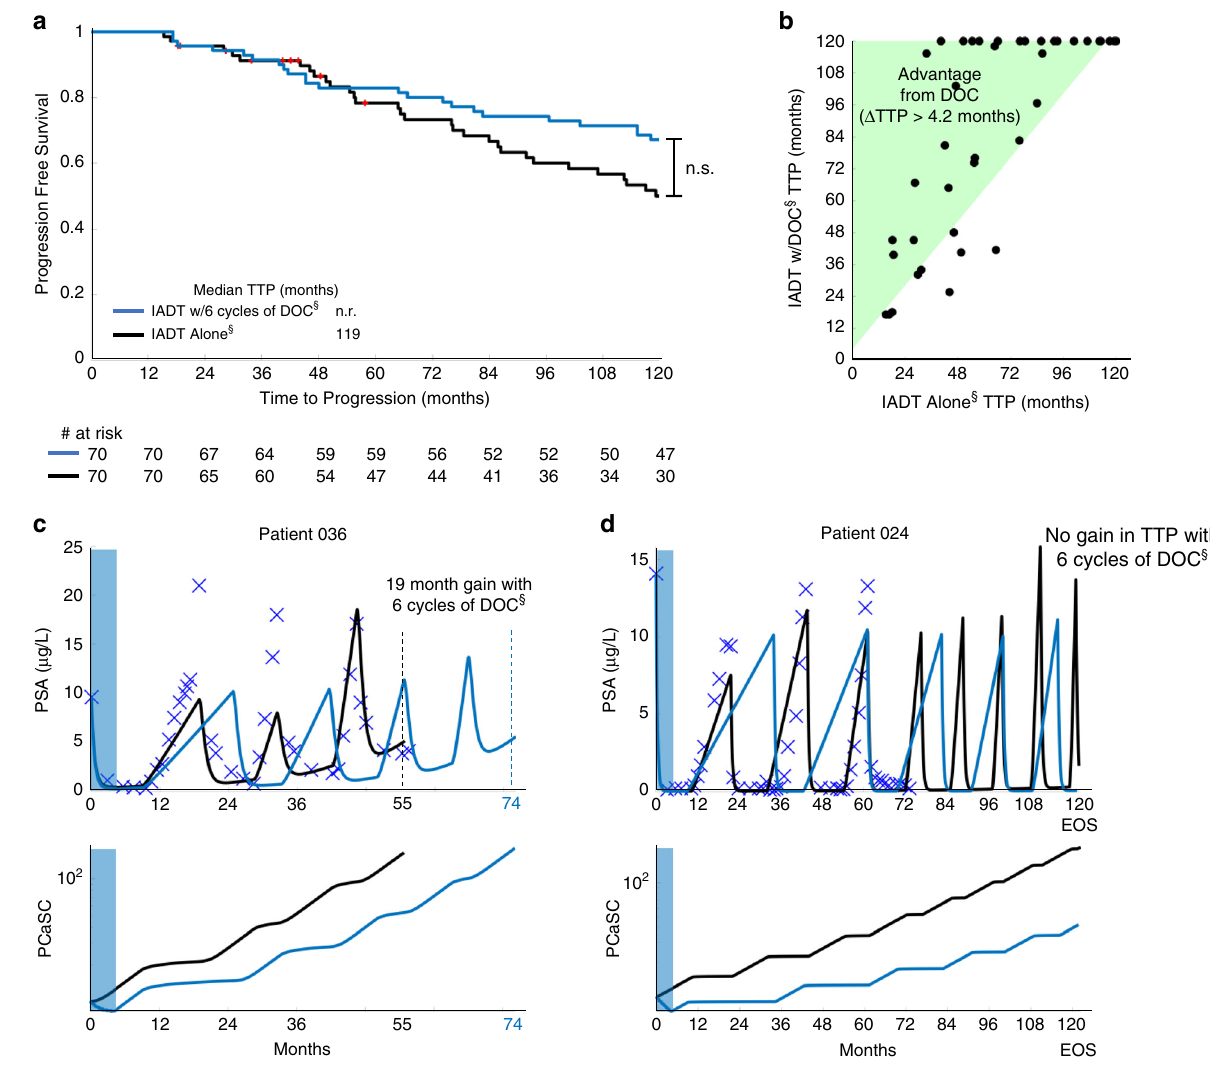
Fig. 7 Docetaxel administration applied prior to IADT progression can increase TTP. a Kaplan – Meier estimates of progression comparing IADT (black) against IADT with induction DOC (blue) (double S indicates predictive model simulation). Red symbols denote patients who experienced an adverse event/death prior to the conclusion of the trial. Statistical signi fi cance was determined using logrank test ( p = 0.260). b TTP comparison between IADT alone and IADT with induction DOC. Shaded area shows where TTP for IADT with induction DOC is >4.2 months longer. c – d IADT simulations with (blue) and without (black) induction DOC. c With IADT alone, Patient 036 developed resistance after 55 months. IADT with induction DOC delayed progression for an additional 19 months. d Though the trial concluded after 6.5 years, simulations shows that Patient 024 could have remained on the IADT protocol for at least 10